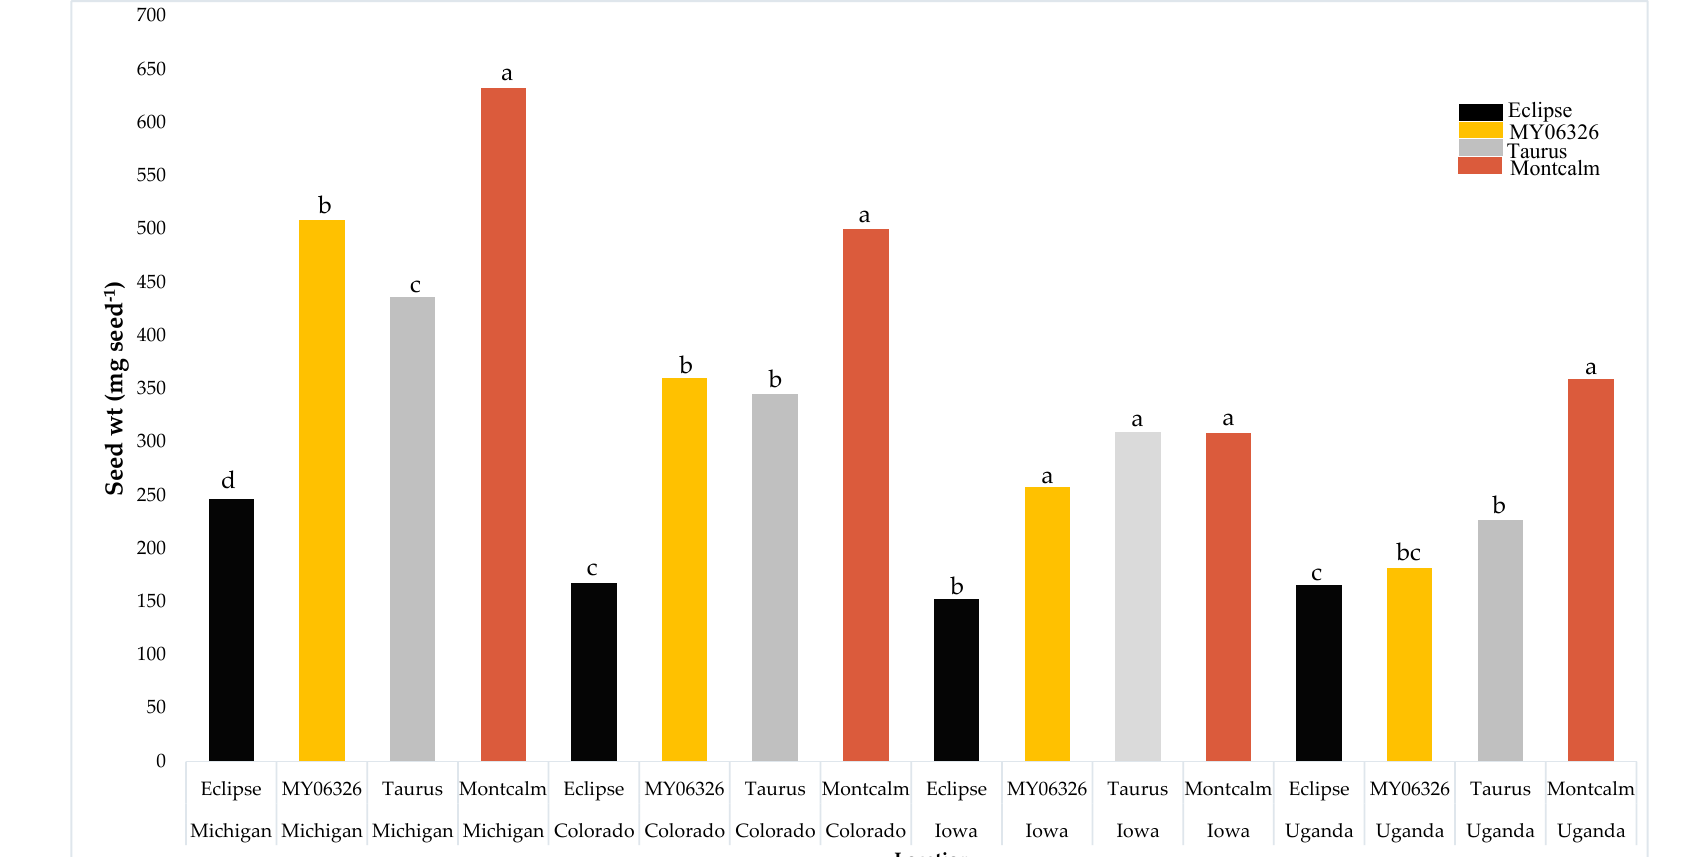
Figure 2. Common bean seed weight (mg seed − 1 ) of four genotypes (Eclipse, MY06326, Taurus, Montcalm) grown in Michigan, Colorado, Iowa and Uganda. Means within a location with different letters differ at P = 0.05 by Tukey-Kramer test. Location × variety SE = 36.